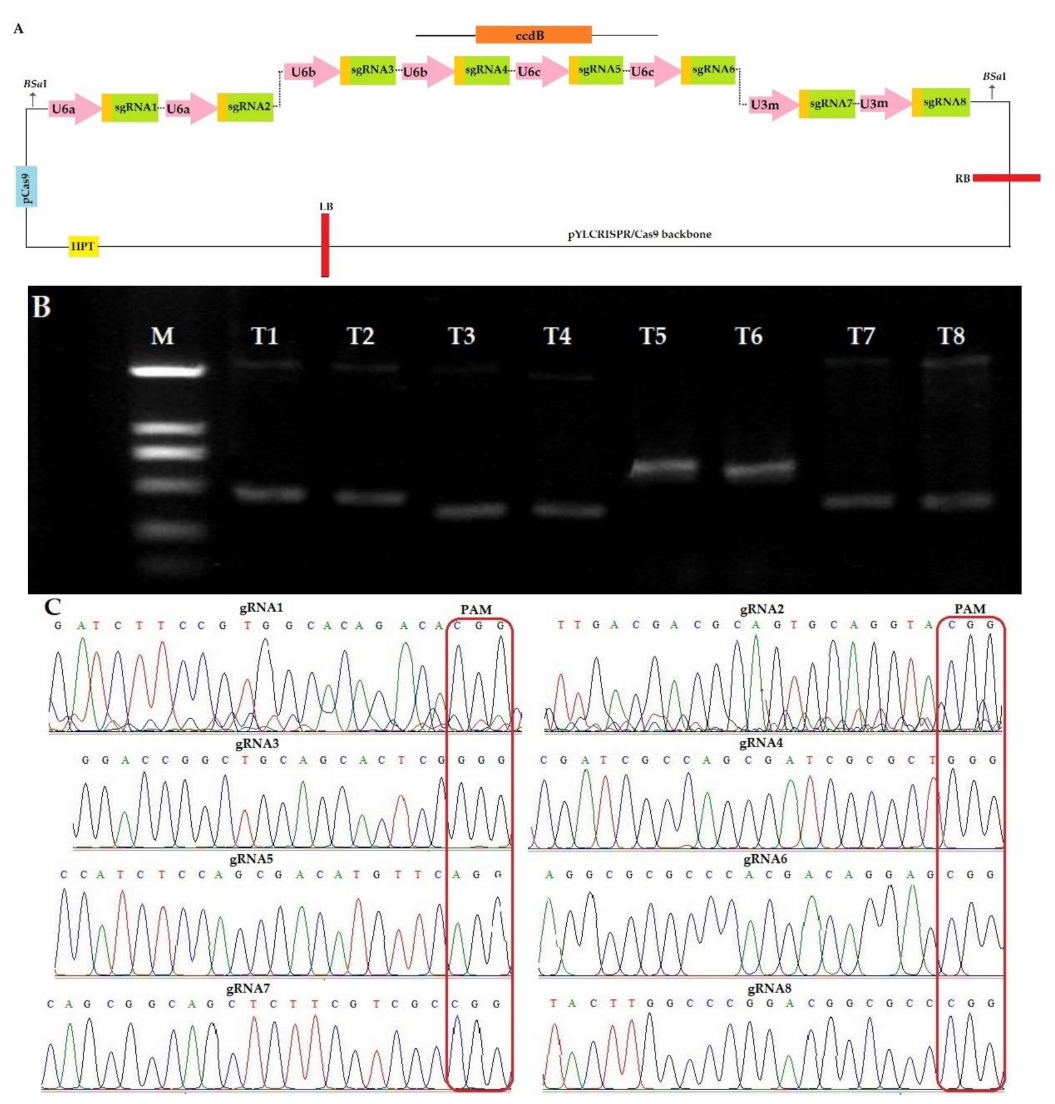
Figure 1. Illustration of target sites and assembly of single guided RNAs (sgRNAs) in pYLCRISPR / Cas9PubiH. ( A ) The illustration of eight sgRNAs in pYLCRISPR / Cas9. ( B ) Product length of all sgRNAs in the second round of PCR, M; molecular marker (2000 bp), T1-T8 represents target1-target8 ( C ) Sequencing confirmation of eight sgRNAs in pYLCRISPR / Cas9PubiH, PAM, protospacer adjacent